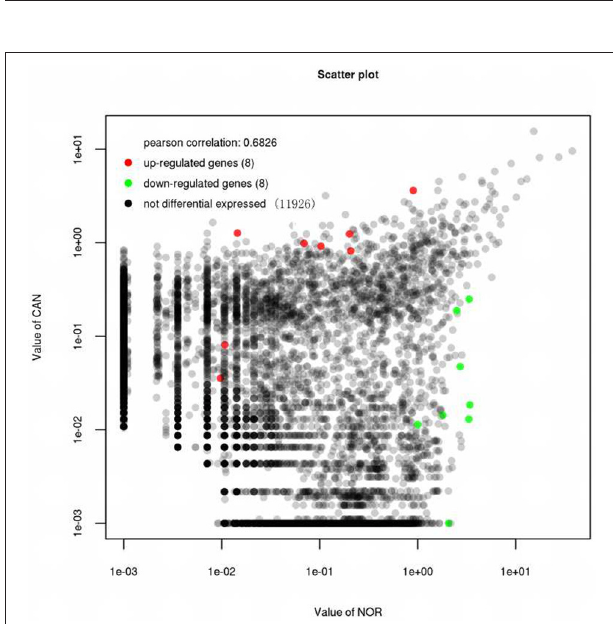
FIGURE 2 | The expression of circRNAs in the eight pairs of OSCC tissue and adjacent normal tissue through the High-throughput Sequencing. 8 circRNAs were up-regulated (red spot) and 8 circRNAs (green spot) were down-regulated in the samples.